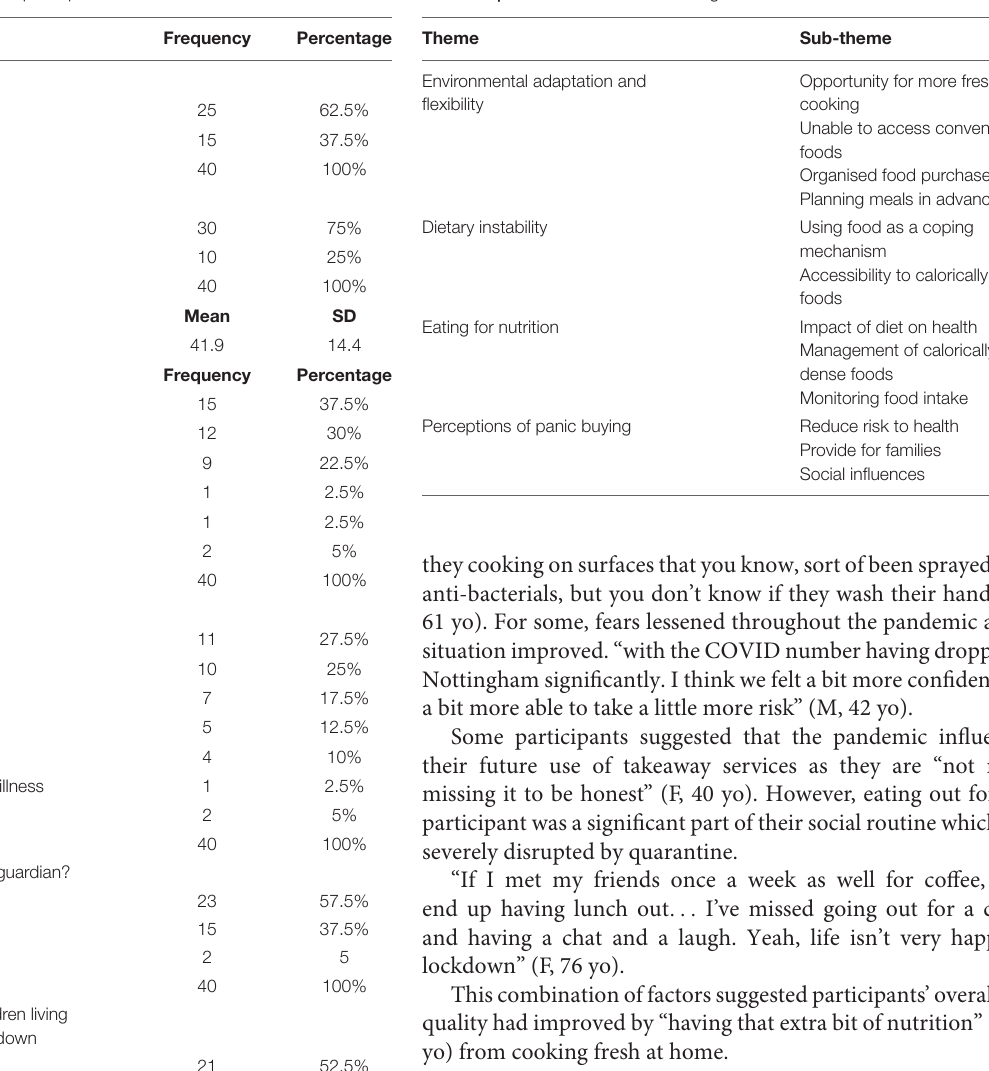
TABLE 2 | Demographic data of participants. TABLE 3 | Themes identified for management of food